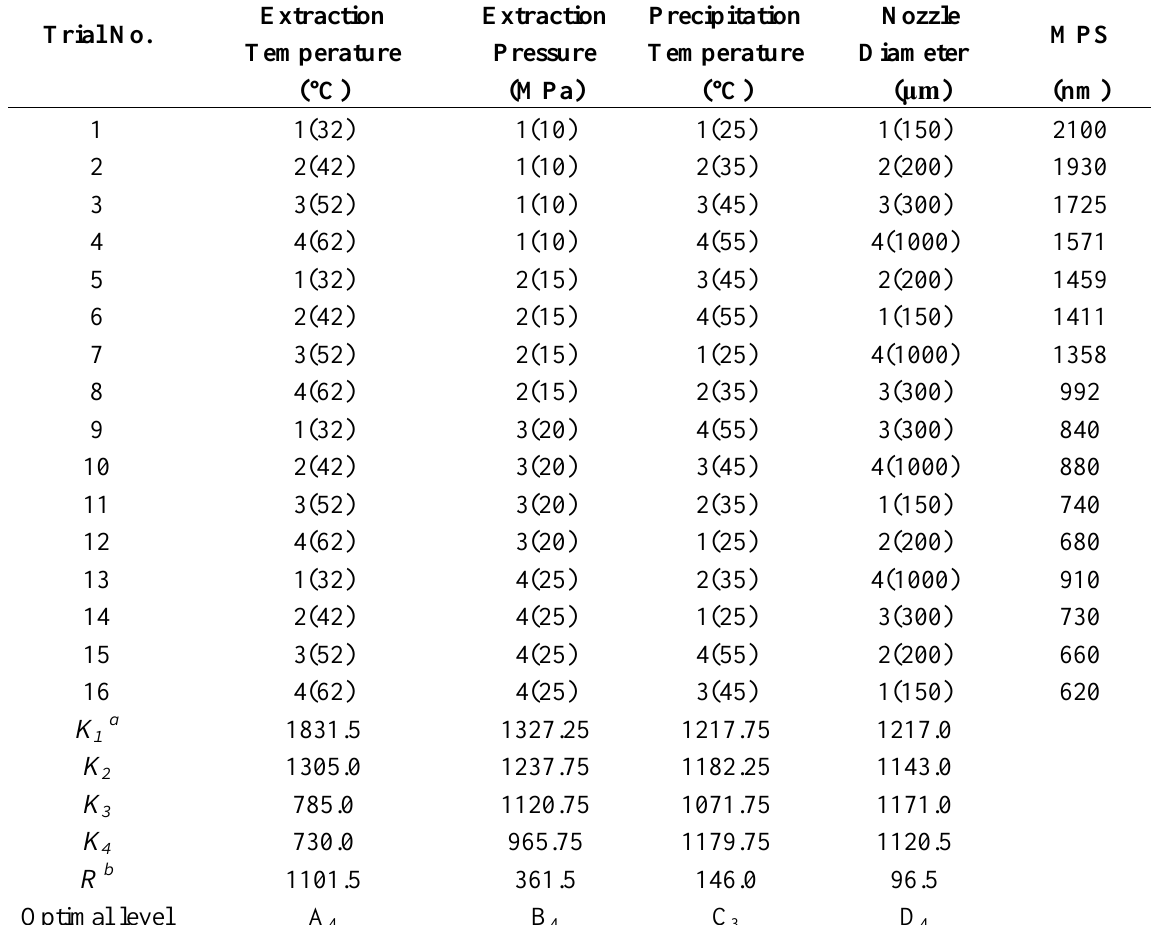
Table 1. Experimental conditions and results for the artemisinin RESS processes. Trial No.